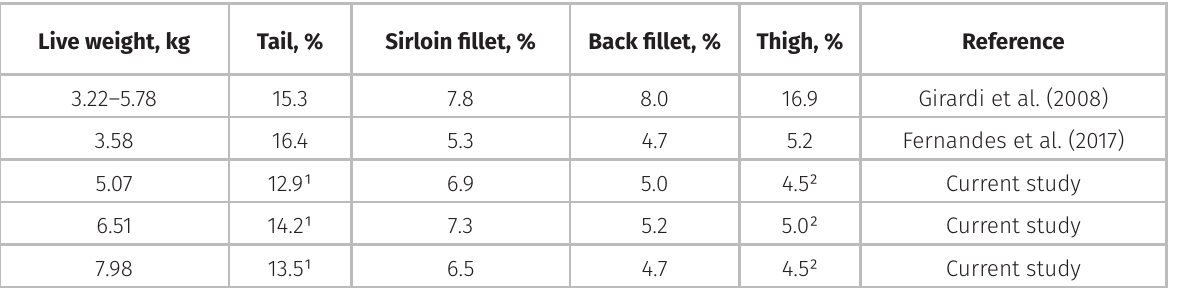
Table V. Yields in relation to the live weight of the animals (compilation). Live weight, kg Tail, % Sirloin fillet, % Back fillet, % Thigh, %